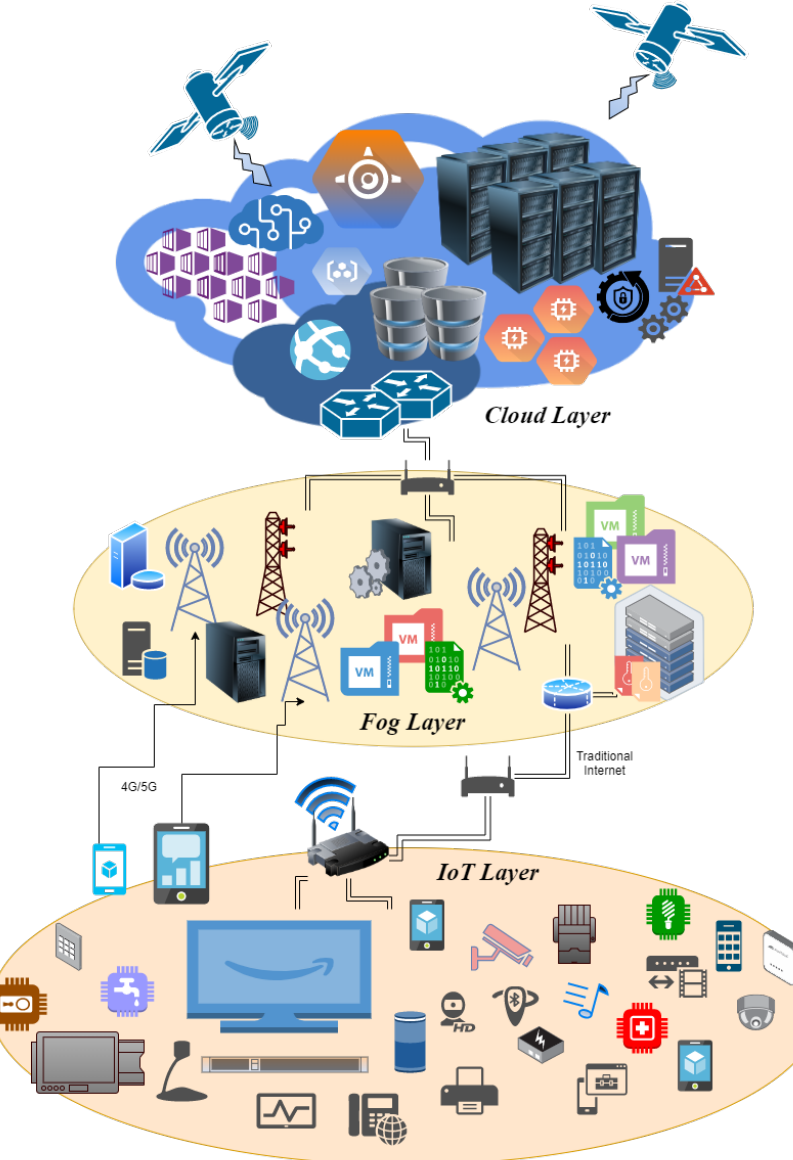
Figure 2. Layered architecture with fog